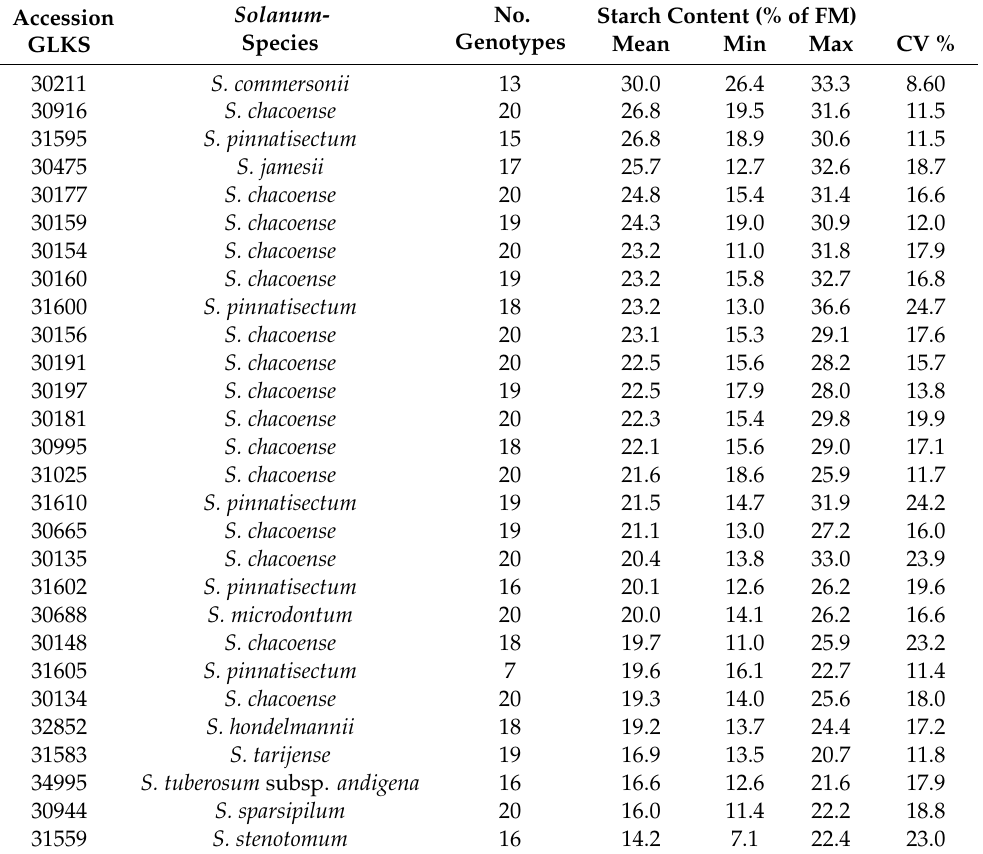
Table 1. Wild potato accessions of the Gross Luesewitz Potato Collections (GLKS) used in the study ranked according to their tuber starch content. Given are the number of genotypes tested per accession, the mean starch content (%) in the tubers, its minimum and maximum values and the coe ffi cient of variation (CV